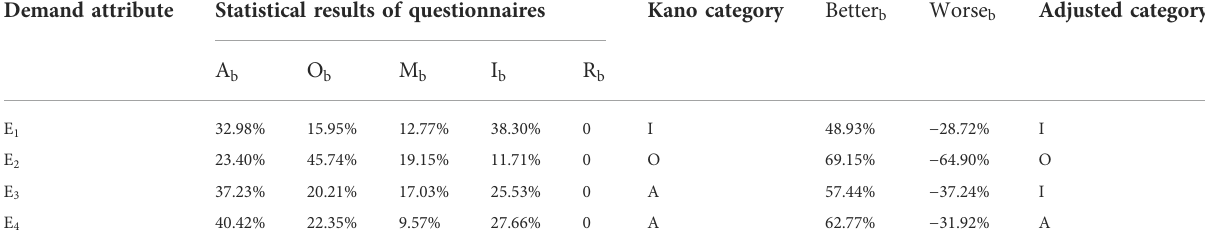
TABLE 10 Kano category of demand attribute E b . Demand